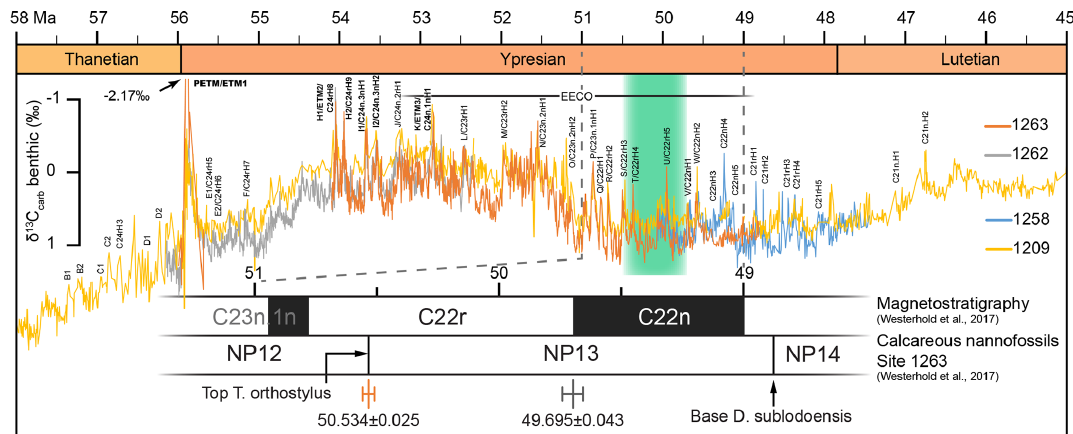
Figure 1. Late Palaeocene and early Eocene benthic carbon isotope record from Sites 1209, 1258, 1262, and 1263. Top of Chron C22r and top of T. orthostylus zone from site 1263 from Westerhold et al. (2017). Hyperthermal nomenclature from Cramer et al. (2003), Lauretano et al. (2016), and Westerhold et al. (2017). Castissent Fm. extension in green.